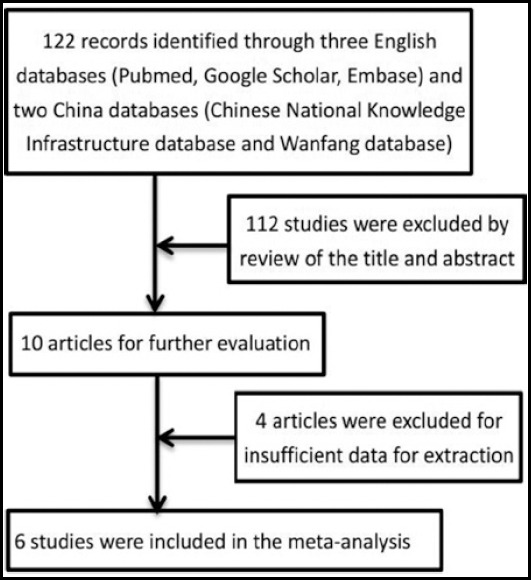
Flow diagram of process for identification of studies.